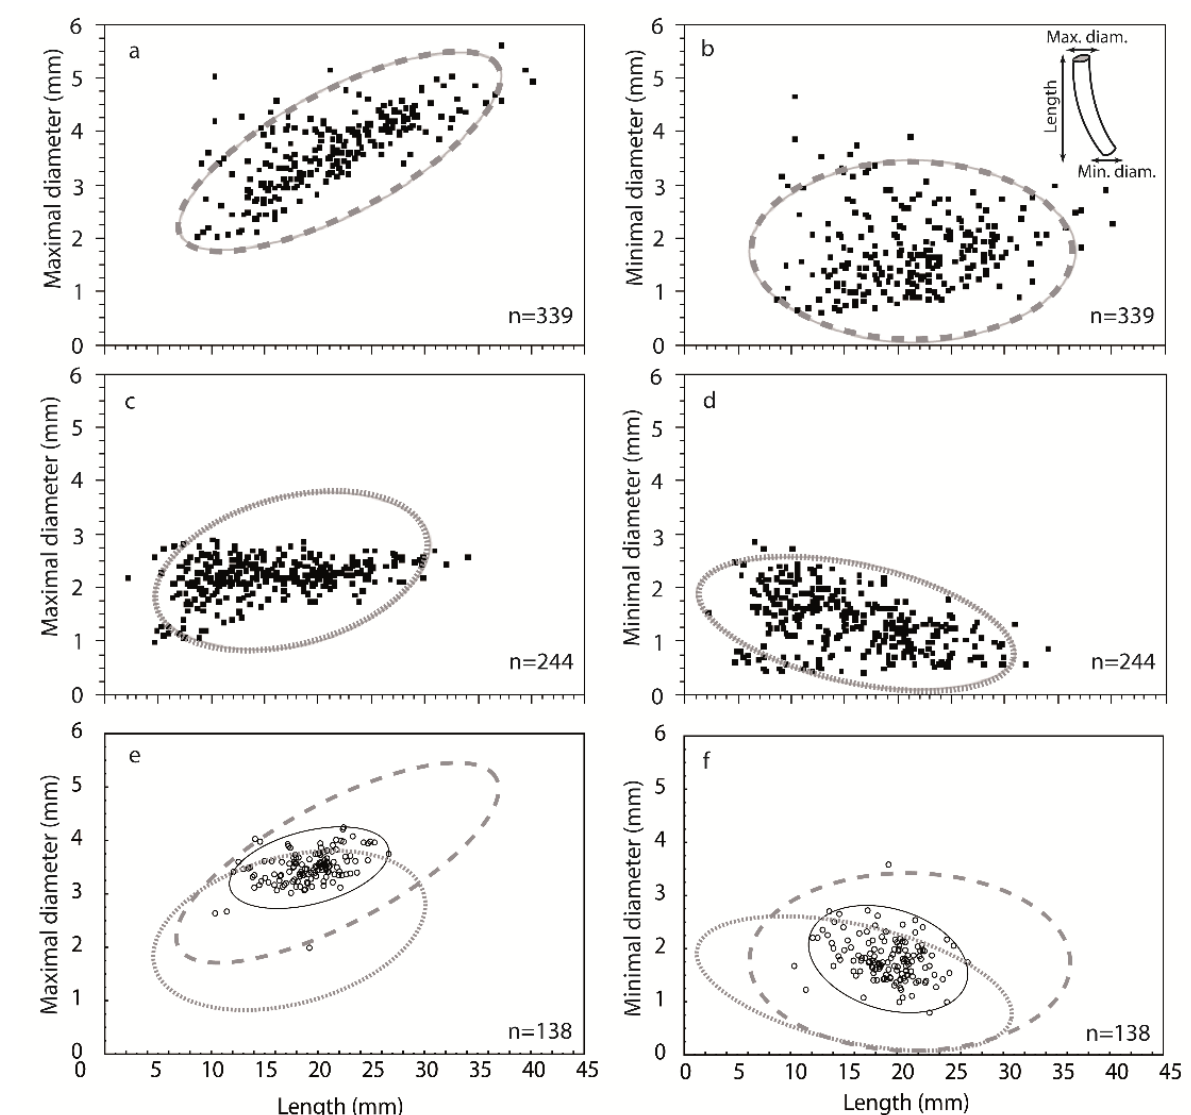
Figure 11: Scatterplot of the length and both maximal and minimal diameters of the Dentalium sp. From, the modern reference collection (a, b), fossil reference collection (c, d) and (e, f), comparison between the confidence ellipse (black) of the archaeological Dentalium sp. And those from modern and fossil (dotted lines) shells (confidence ellipses=